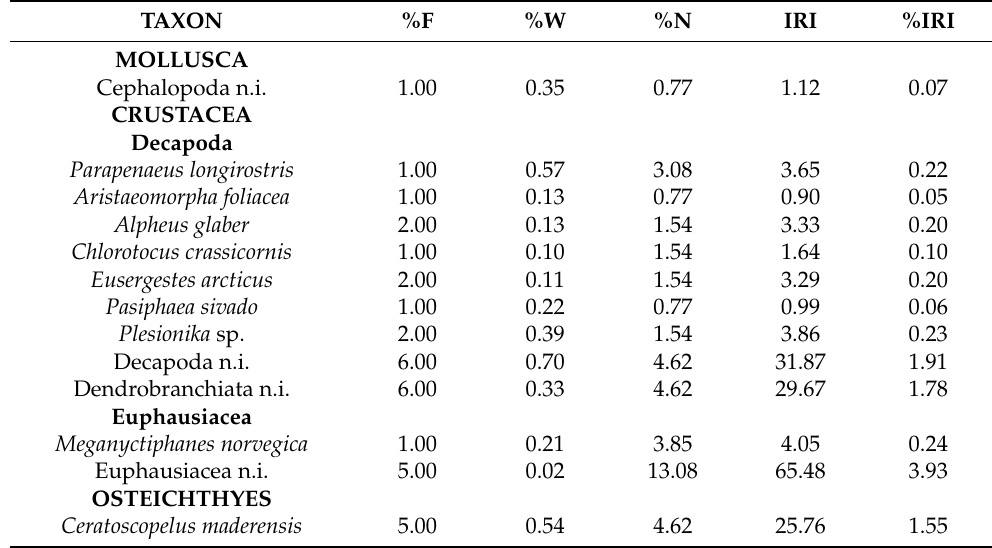
Table 5. Diet composition of the whole hake series from southern and central Tyrrhenian Sea sampled in 2018. In the columns are reported the diet index values (%F, %W, %N, IRI and %IRI) for each prey category.